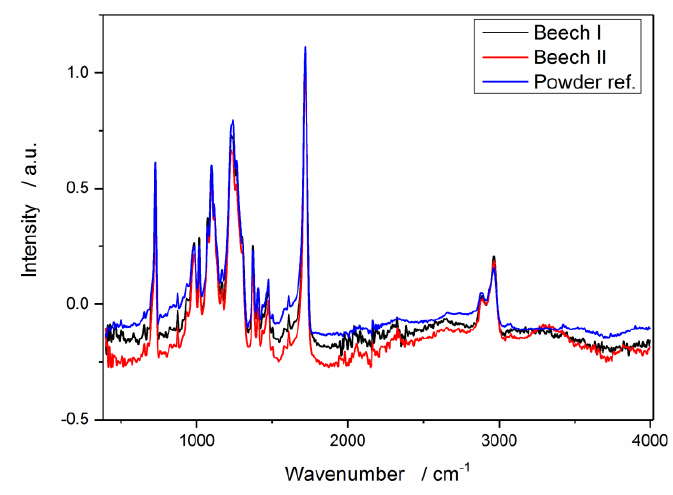
Figure 4. Comparison of FTIR spectra of single- and double-coated beech and the powder reference. All spectra are corrected by moving average baseline subtraction.